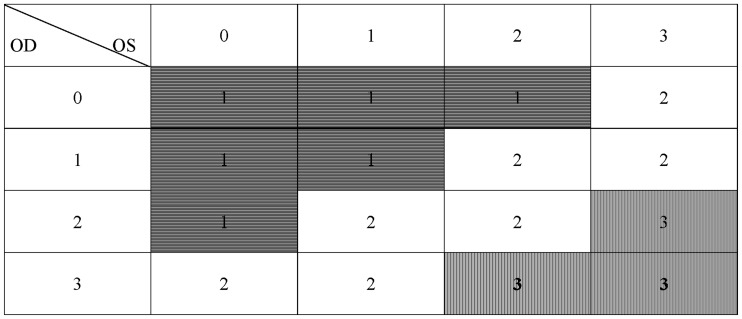
The classification of visual field in POAG patients.*Level 1 = Horizontal stripes, level2 = blank and level 3 = Vertical stripes.